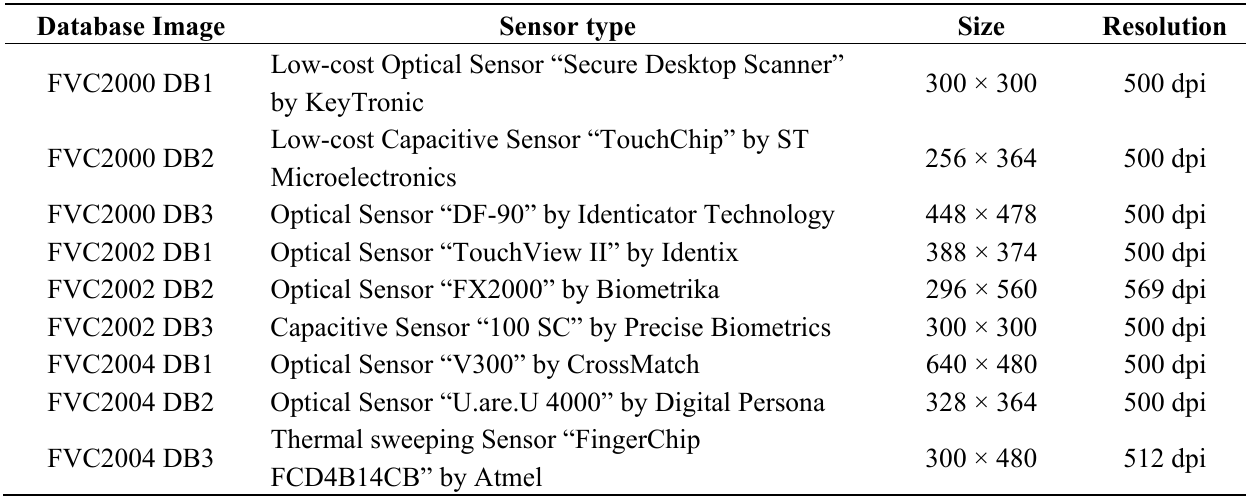
Table 1. FVC fingerprint database sensor